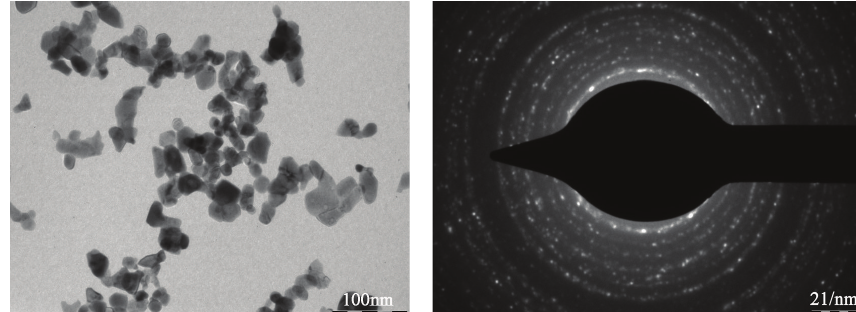
Figure 2: TEM micrograph and SAED pattern of nano-BaWO 4 .